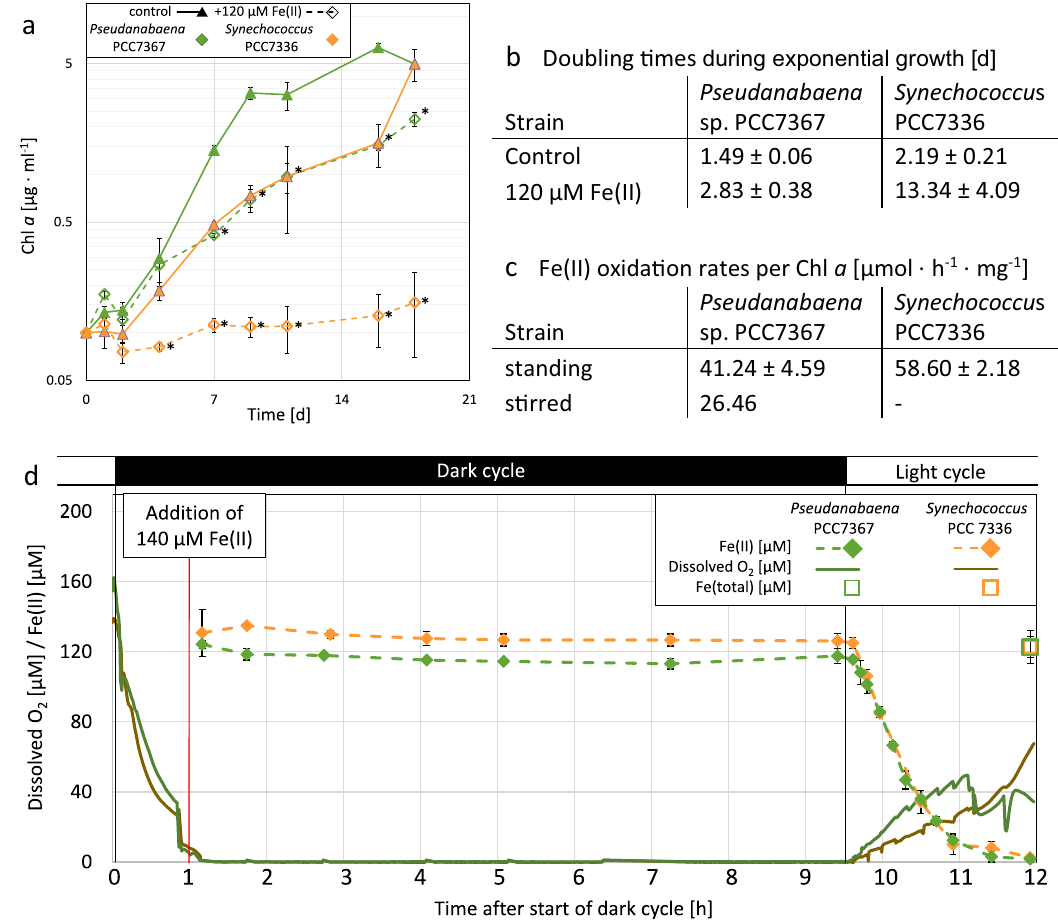
Fig. 3 The in fl uence of reoccurring nightly addition of Fe(II) on the growth of Pseudanabaena sp. PCC7367 and Synechococcus sp. PCC7336. Both species were cultured in an open-culture system ( a , b ) and the oxidation of Fe(II) monitored ( c , d ). Chl a growth curves ( a ) and doubling times ( b ) of the cultures in an anoxic open-culture system with a recurring nightly addition of 140 µ M Fe(II). For the fi rst 12 days during every dark cycle, the cultures were shaken brie fl y to release the dissolved oxygen and Fe(II) solution was added to a total concentration of 120 – 140 µ M. Chl a measurements ( a ) were taken every 2nd to 3rd day for 19 days. Cultures grown without Fe(II) addition were used as controls (solid line). Cell doubling times during the exponential growth ( b ) were determined from day 2 to 12 for both strains. The retention of Fe(II) during the dark cycle ( d ) was exemplary tested in analogous 7-day old, exponentially growing control cultures of Pseudanabaena sp. PCC7367 (green) and Synechococcus PCC7336 (orange) by measuring the Fe(II) concentration (dashed lines), while in parallel recording the oxygen concentration (solid line). The Fe(II) oxidation was measured every 10min with a spectrophotometric ferrozine assay. Two hours after the start of the light cycle, the amount of Fe(III) in the media was assessed (open squares). The average rate of Fe(II) oxidation per Chl a during the light cycle ( c ) was calculated and compared to cultures which were additionally stirred at constant 250 rpm on a magnetic stirrer. Data are presented as mean values±SD with n = 4 biologically independent samples, except for the stirred Fe(II) oxidation rate with n = 2 biologically independent samples. Asterisks ( * ) represent a signi fi cant difference between Fe(II) supplemented culture and control ( p < 0.05, Student ’ s t -test,